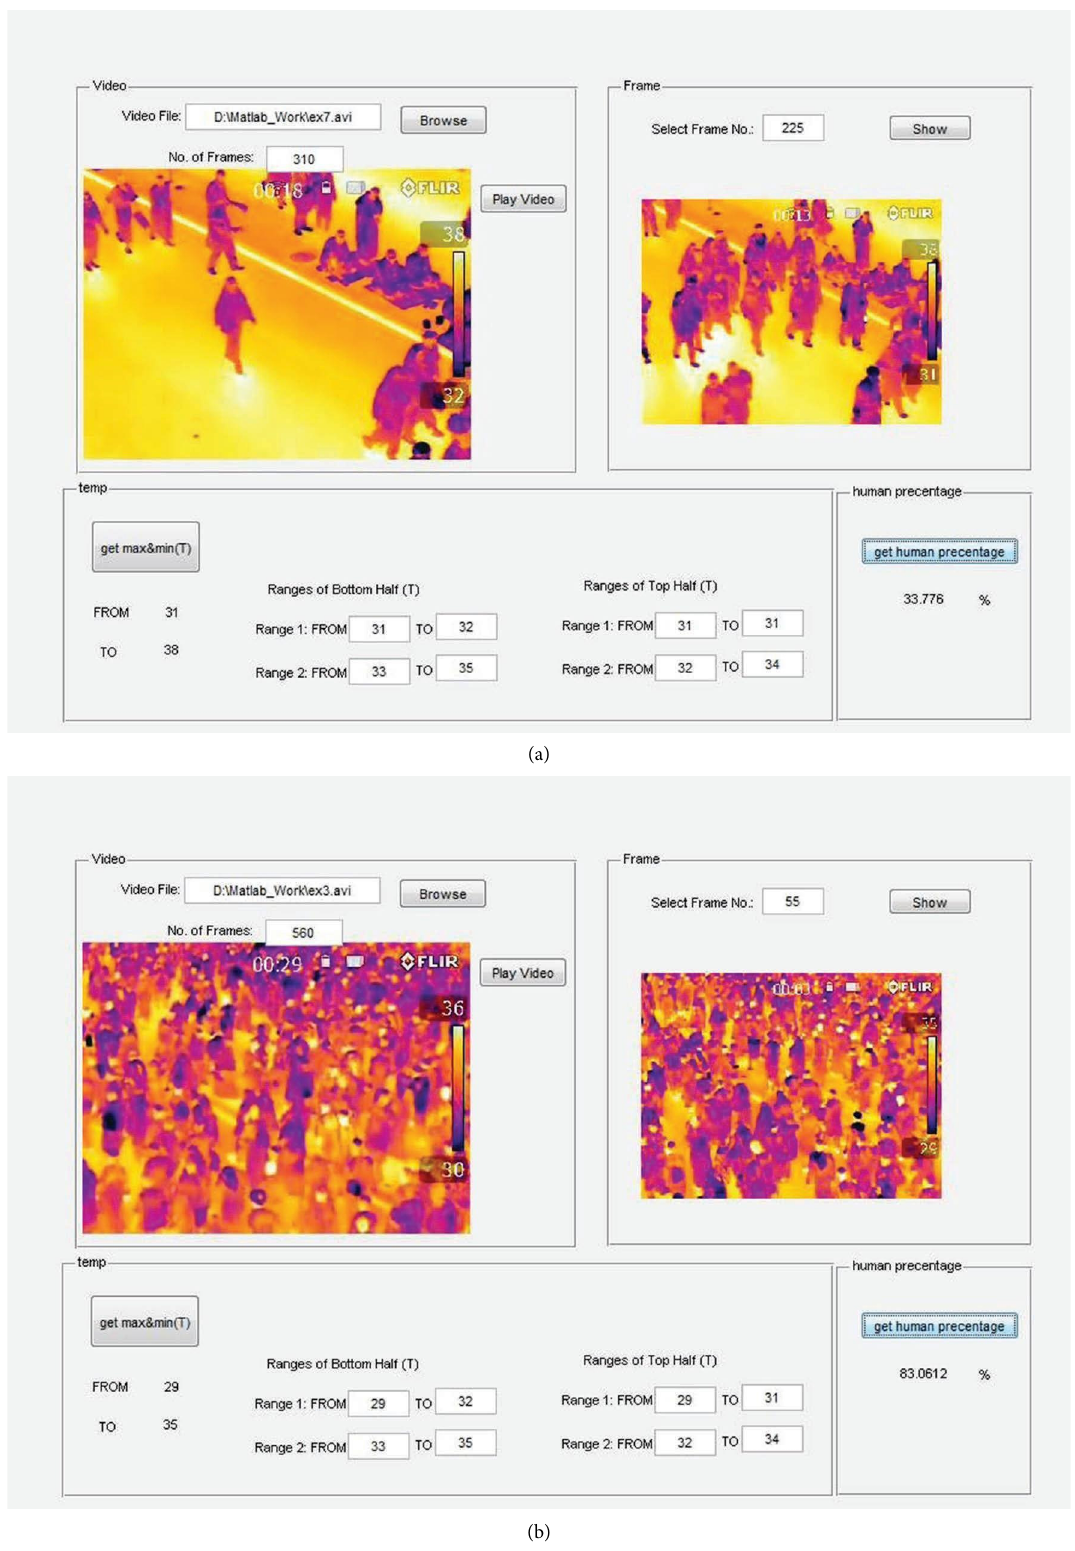
Figure 12: (a), (b) Samples of the accuracy rate for the enhancement which is based on diferentiating between the individual distances from the thermal camera which is required to estimate the intensity of individuals on